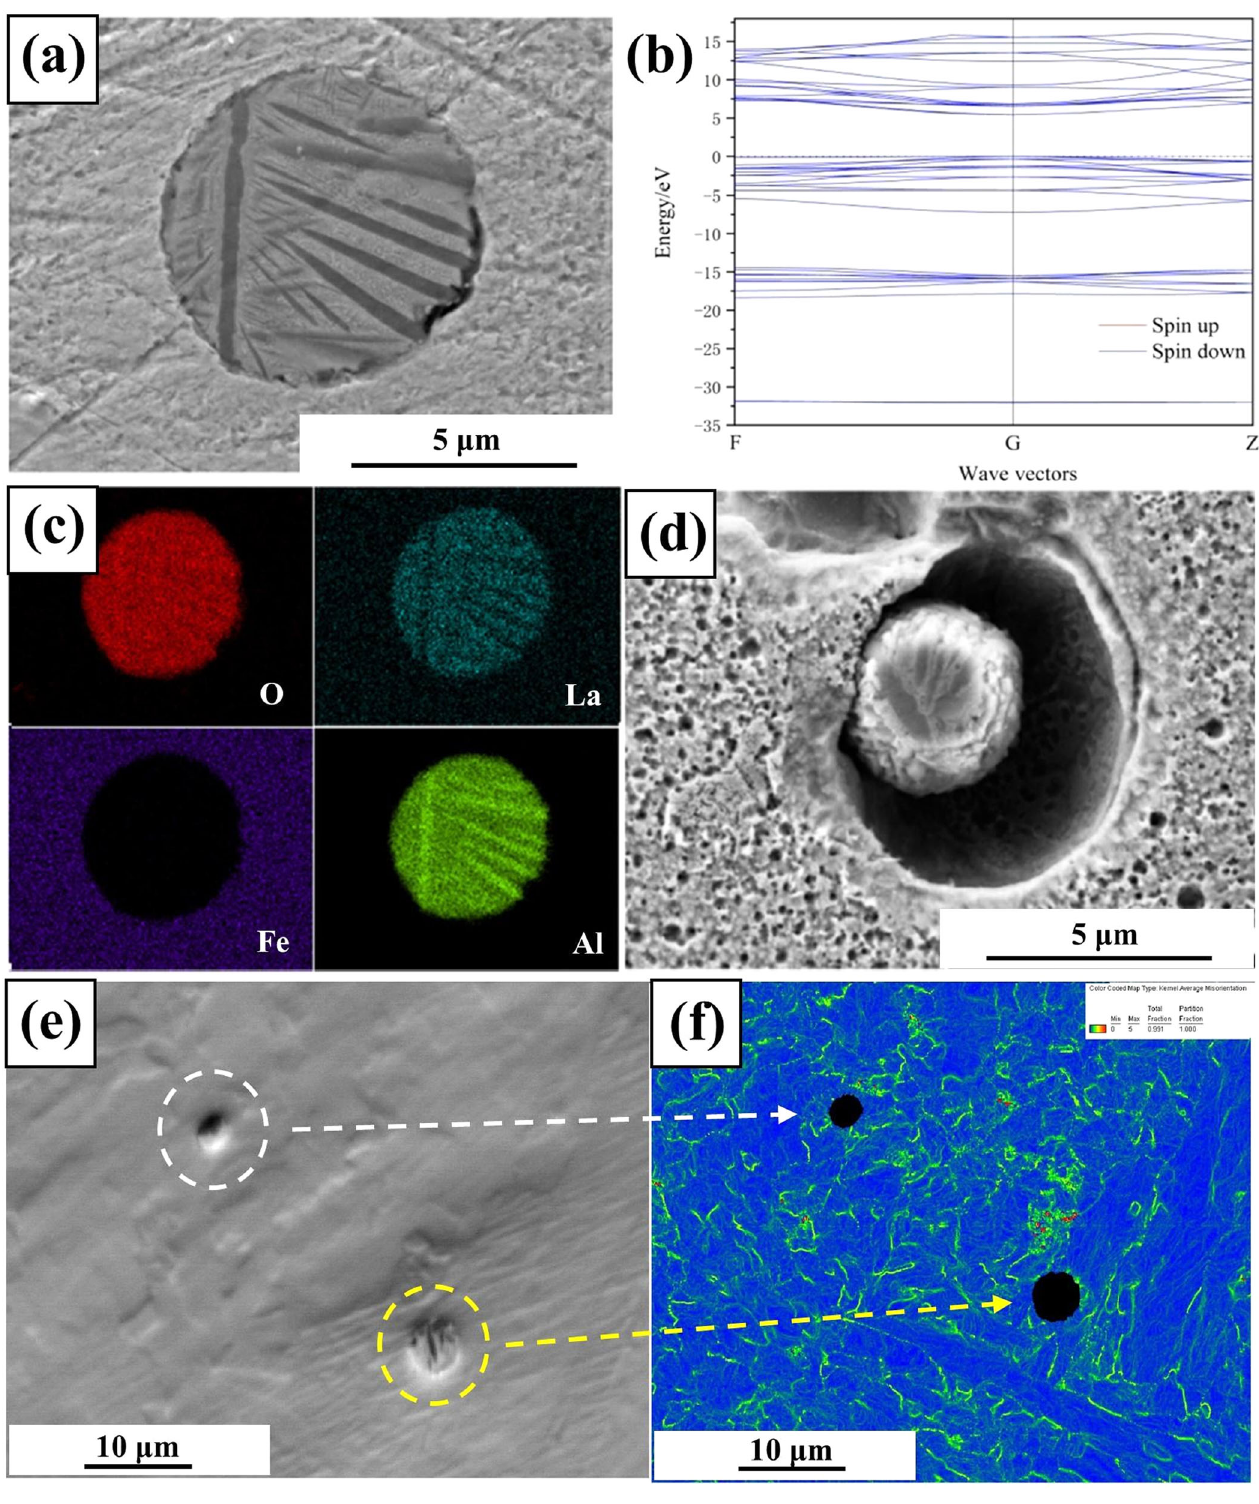
Fig. 13 Characterization and corrosion test for LaAlO 3 inclusion. a SEM photographs and c the element distribution of target LaAlO 3 inclusion. b Typical energy band structure analysis results of LaAlO 3 inclusion. d Morphology observation of the same region as a after immersion in 0.62 M NaCl solution for 80 min. EBSD images of a region containing LaAlO 3 inclusions: e SEM images and f the corresponding KAM map of the same region shown in e , the white and yellow dashed circles in e corresponds to the target inclusions with black contrast shown in f 23